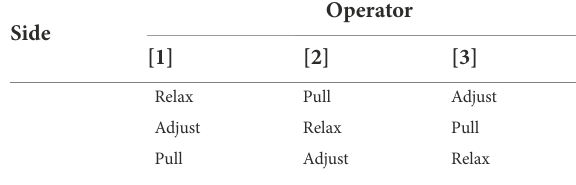
TABLE 1 Three heterogeneous roles required in the coordinated drawing task ( Figure 1A